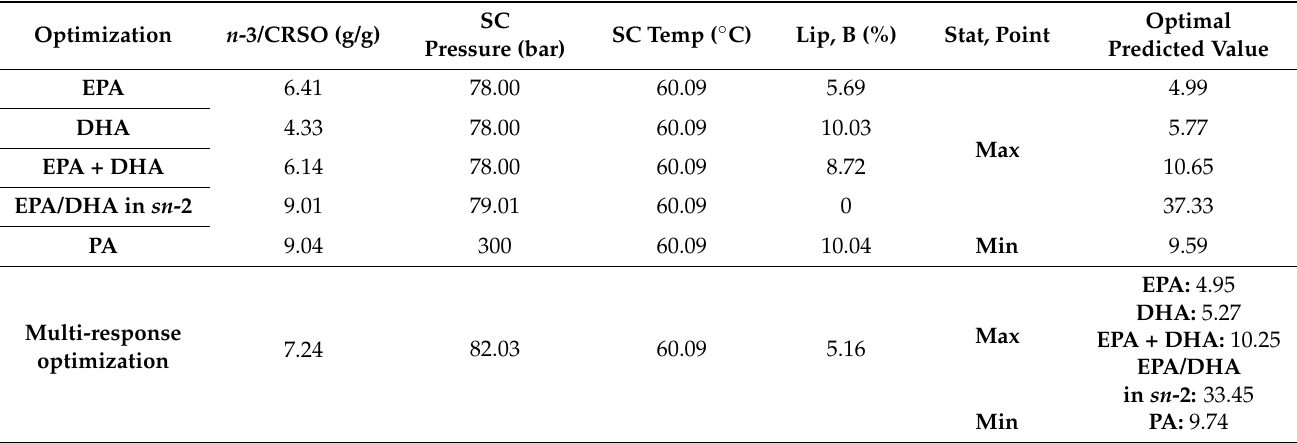
Table 2. Optimal values of the independent variables n -3/CRSO ratio, SC pressure, SC temperature, and enzyme percentage to maximize the EPA, DHA, EPA+DHA, and EPA/ DHA in sn -2 responses by SAcyl, and the multi-response optimization of these variables *.